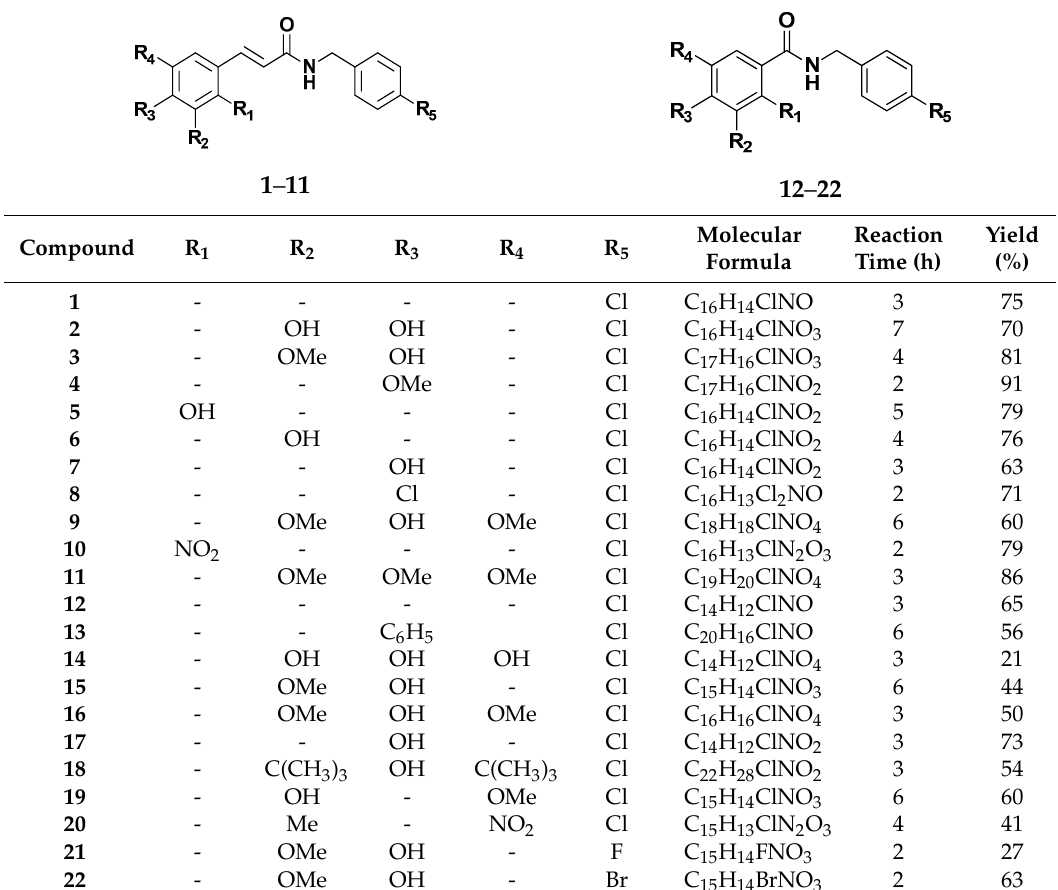
Table 1. Data for amides derived from cinnamic acid and benzoic acid.